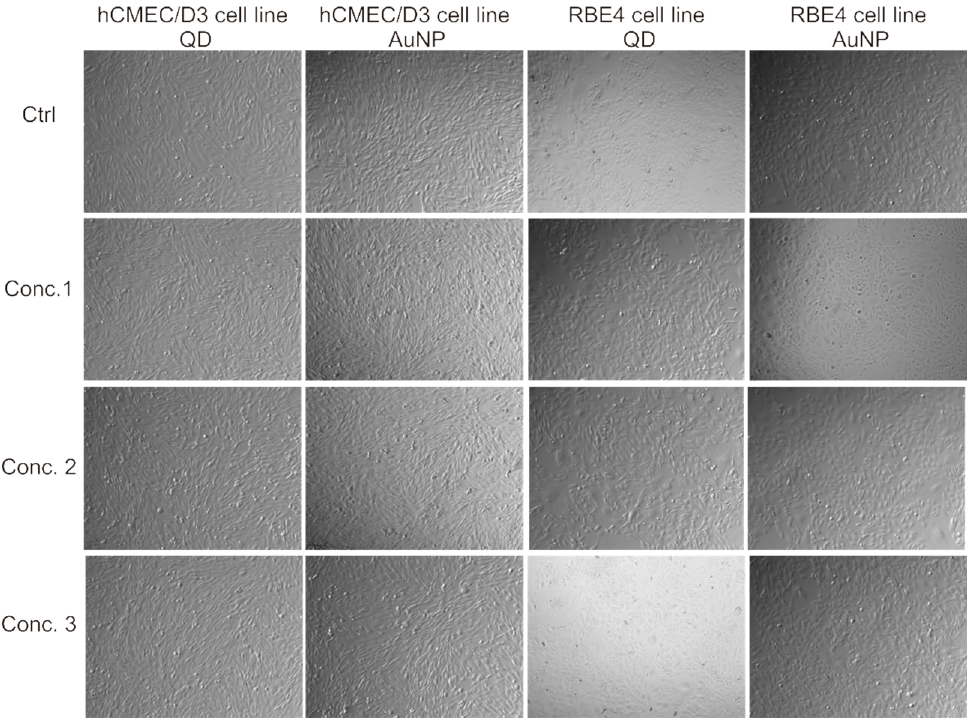
Figure 1. Morphology of brain microvascular endothelial cells (BBB cellular model) treated with nanoparticles. Microphotographs at 125× magnification taken using a Nikon Eclipse TE2000 microscope with a phase contrast objective. Columns one and two contain images of the hCMEC/D3 cell line, columns three and four of the RBE4 cell line. Concentrations of respective nanoparticles, labeled on the left and referring to each row of images, are as follows: for quantum dot nanoparticles (QD), concentration 1 is 0.1, 2–1, 3–10 µg/mL; for gold nanoparticles (AuNP), concentration 1 is 0.1, 2–0.5, 3–1 µg/mL.